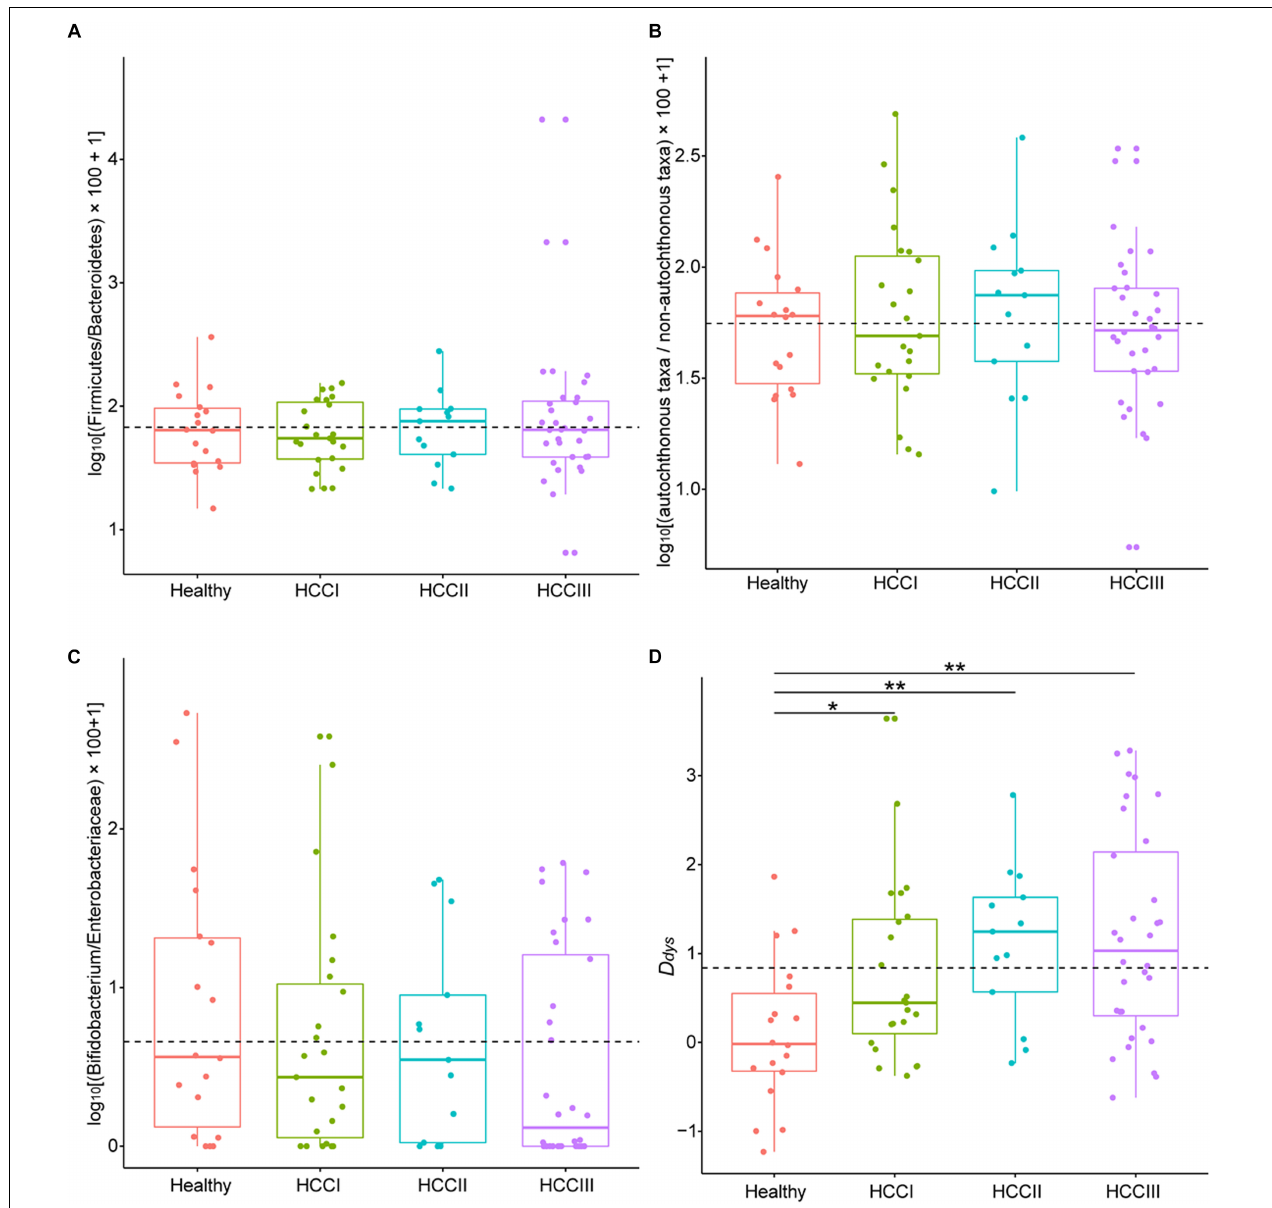
FIGURE 3 | Boxplots showing changes by degree of dysbiosis. Description of indices and how they were calculated (A) based on the relative abundance of Firmicutes and those of Bacteroidetes, (B) based on the relative abundance of autochthonous taxa and those of non-autochthonous taxa, (C) based on the relative abundance of Bifidobacterium and those of Enterobacteriaceae, and (D) based on seven probiotic bacterial genera ( Anaerostipes , Bifidobacterium , Coprococcus , Faecalibacterium , Lactobacillus , Oscillibacter , and Phascolarctobacterium ) and 13 harmful bacterial genera ( Akkermansia , Bacteroides , Clostridium , Dorea , Escherichia , Fusobacterium , Haemophilus , Helicobacter , Klebsiella , Prevotella , Ruminococcus , Streptococcus , and Veillonella ). Primary HCC samples were staged as previously described (Zhou et al., 2018). ∗∗ p < 0.01; ∗ p <